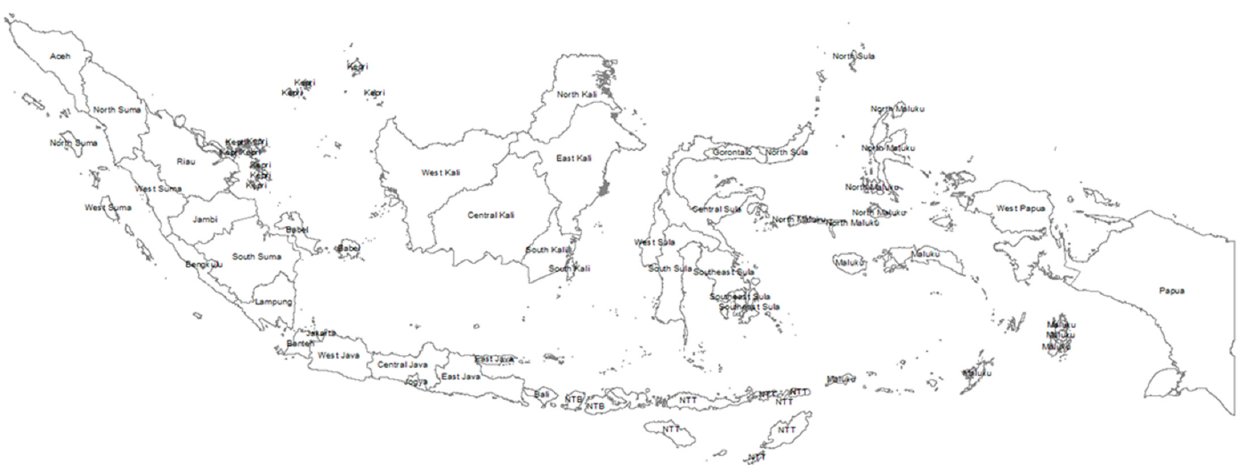
Figure 1. Map of Indonesia by province. Note: Suma = Sumatera, Kepri = Riau Islands, Sula = Sulawesi, Kali = Kalimantan, NTB = West Nusa Tenggara, NTT = East Nusa Tenggara. We divided the provinces into five regions including Sumatera, Java/Bali, Kalimantan, Sulawesi, and Papua/Maluku/Nusa Tenggara. The latter region is the least developed. The Indonesian Information and Geospatial Agency provided the shapefile; the authors created the map in ArcMap 10.